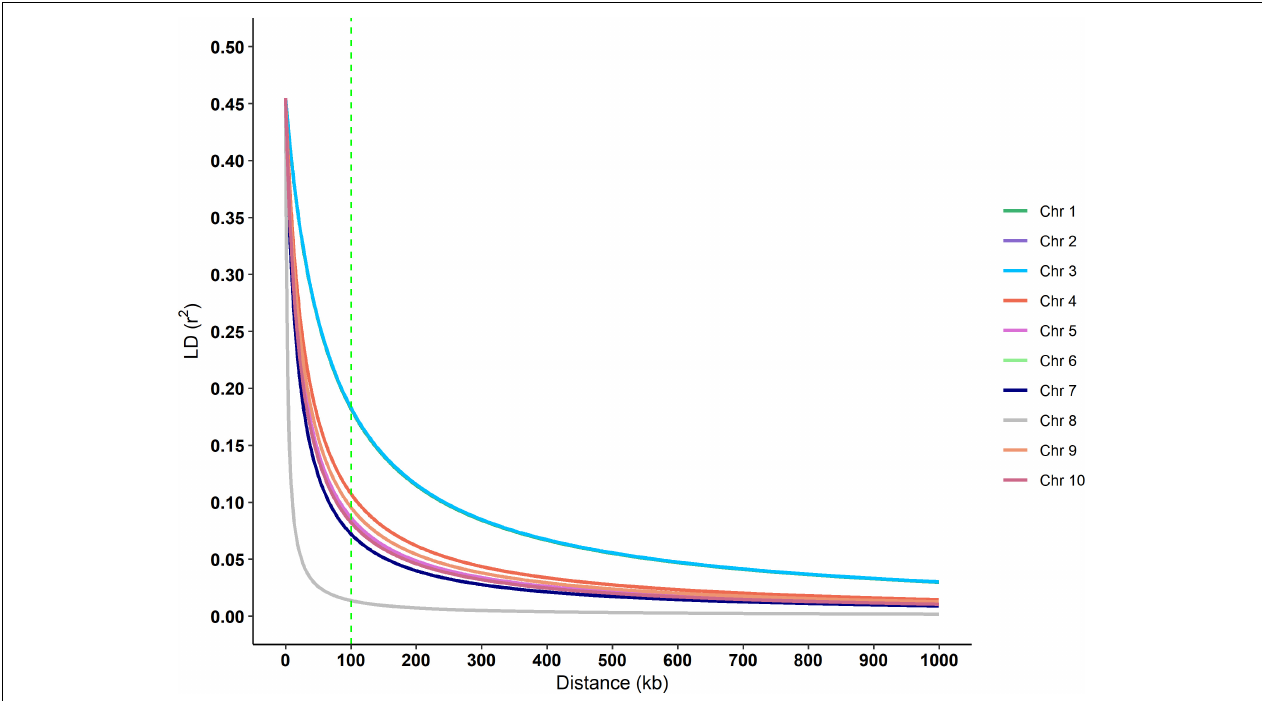
FIGURE 6 | Linkage disequilibrium decay over each chromosome of the BC1S1 population, that is, the breeding population used in this study originated from 20 landraces that undergone through a backcross with an elite line and selfed. The vertical dashed green line indicates the window size used in the annotation process.